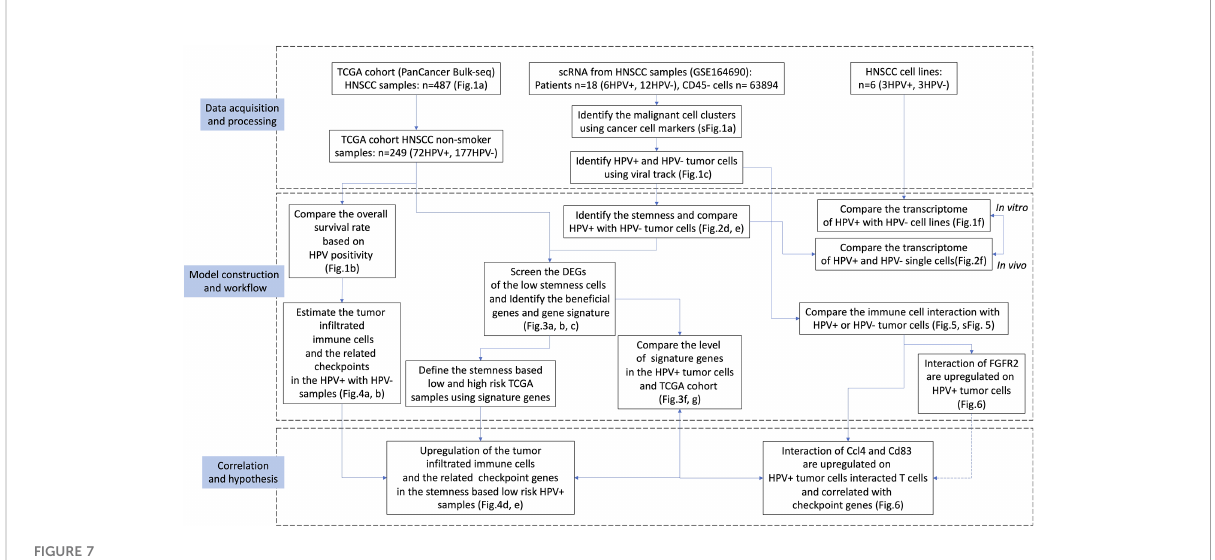
FIGURE 7 Work fl ow of our